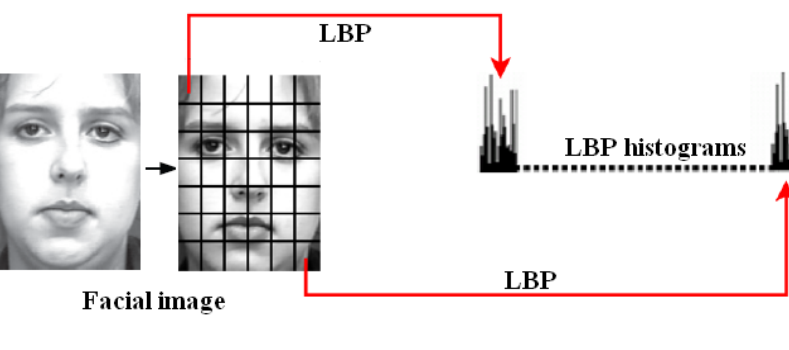
Figure 2. The process of LBP features